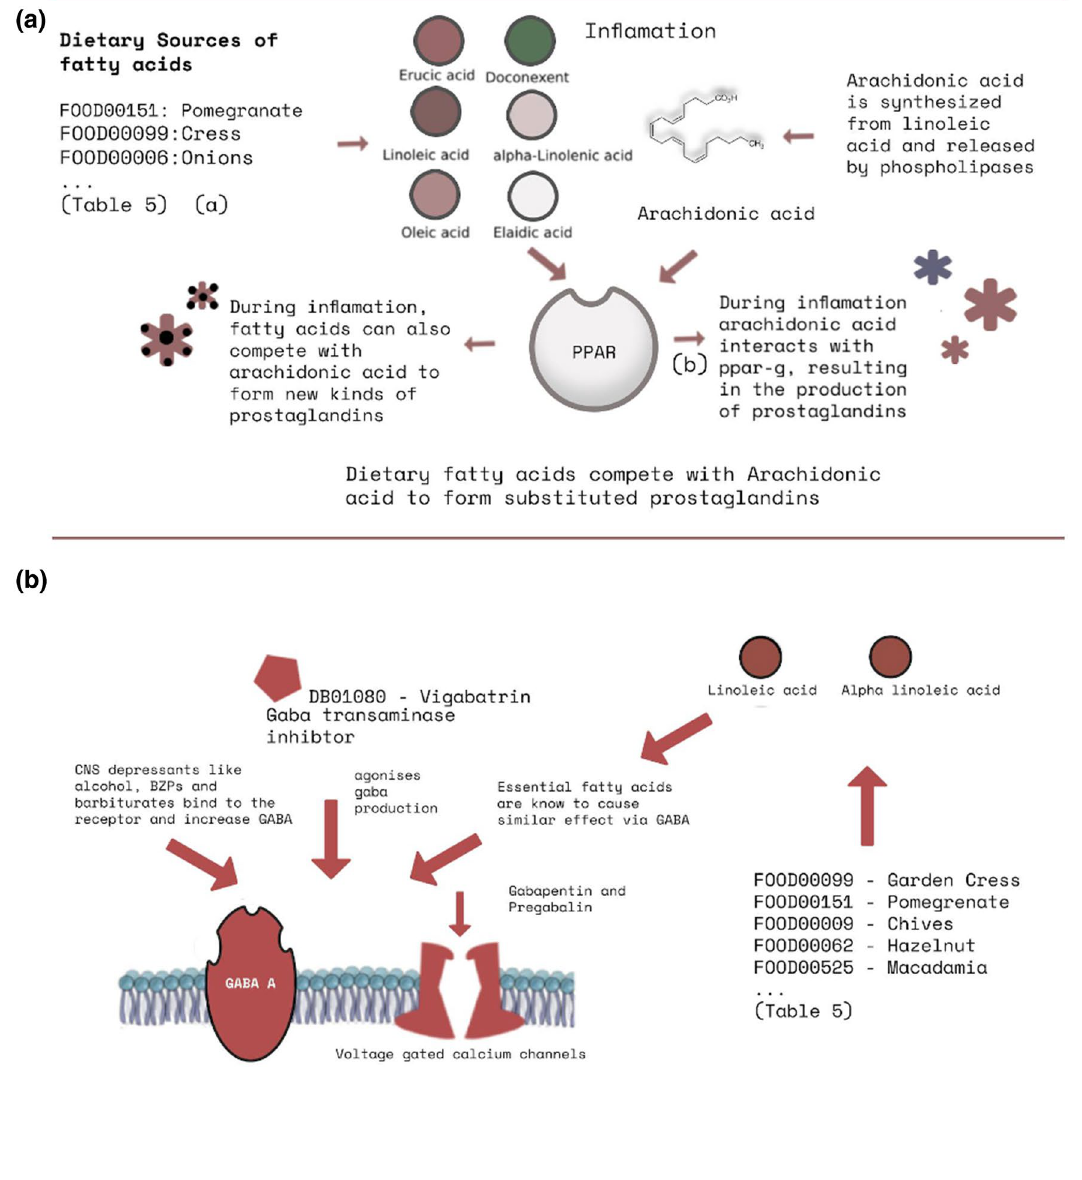
Figure 3. ( a ) An illustration depicting the effect of dietary fatty acids on COX pathway a) Various foods are rich sources of dietary fatty acids ( b ) During inflammation, Arachidonic acid interacts with PPAR to produce prostaglandins ( c ) Dietary Fatty acids can compete with Arachidonic acid during inflammation at PPAR to form substituted prostaglandin variants. ( b ) An illustration depicting Gabaergic drug mechanisms. Dietary sources containing fatty acids increase the production of GABA. Taking drugs like Vigabatrin, pregabalin & Gabapentin with such a diet can increase Gabaergic effects. This figure was generated using Photopea.com online graphics